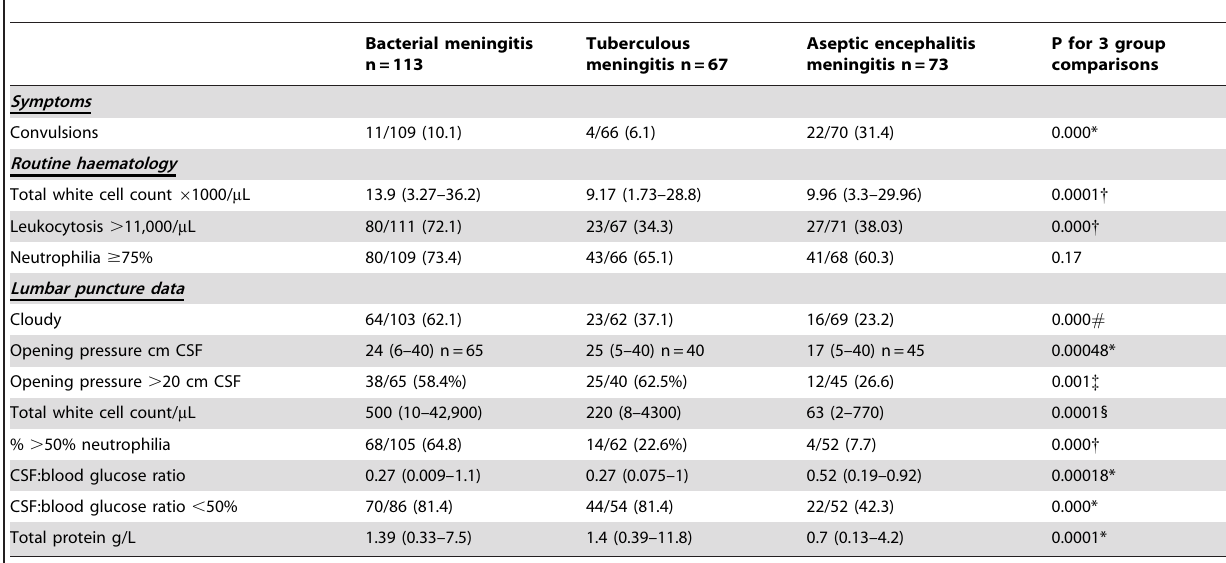
Table 2. Selected patient characteristics when confirmed and clinically suspected diagnoses are